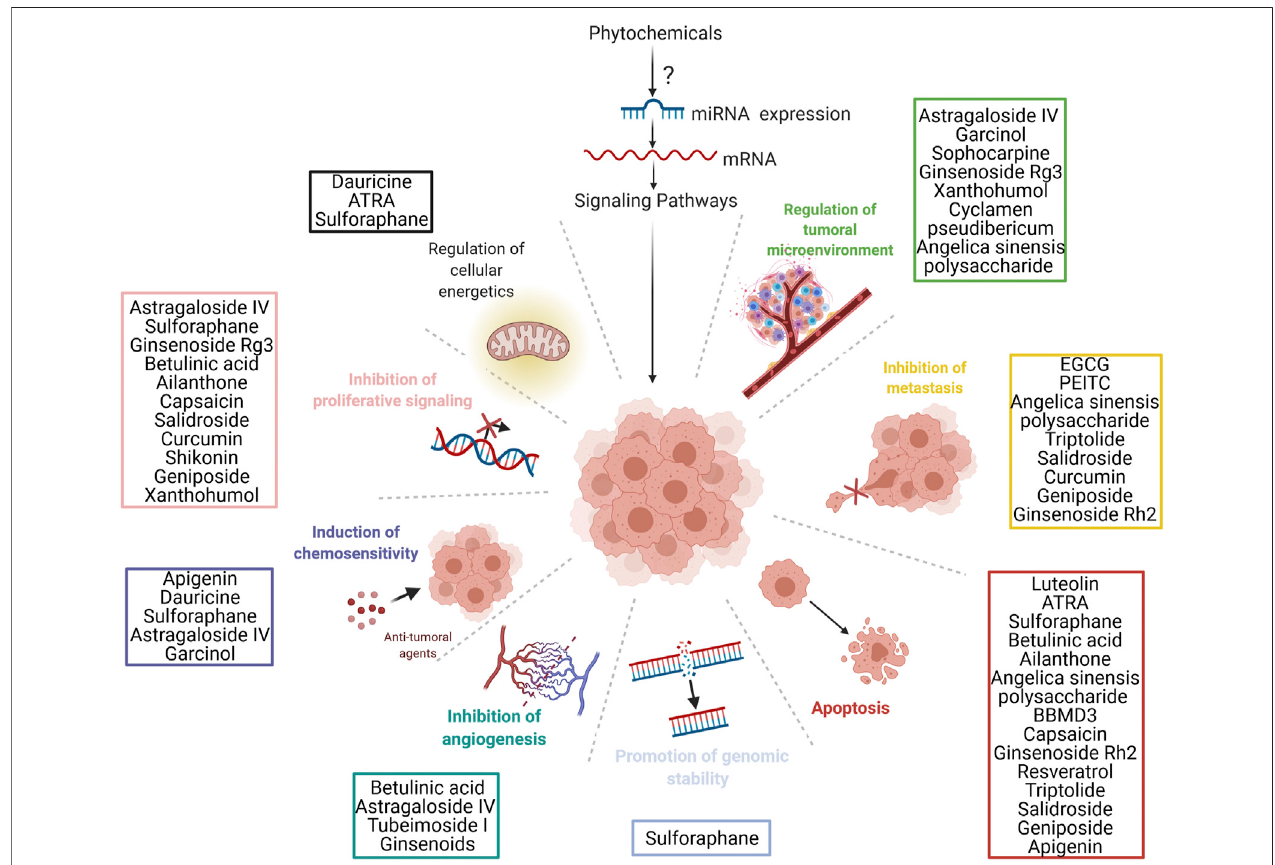
FIGURE5| Thegeneralmechanismsbywhichplant-derivednaturalcompounds(phytochemicals)in fl uencemiRNAexpression.Inturn,thesemiRNAscanalterthe expression of different proteins implicated in several cancer signaling pathways by binding to target mRNA. This alteration at the molecular level then leads to the phenotypicalchangesobserved invitro and invivo .Themajorphenotypicalchangesarerepresentedinthe fi gure.Lastly,themajortypesofnaturalcompoundsandtheir pathways of action are summarized in the fi gure.